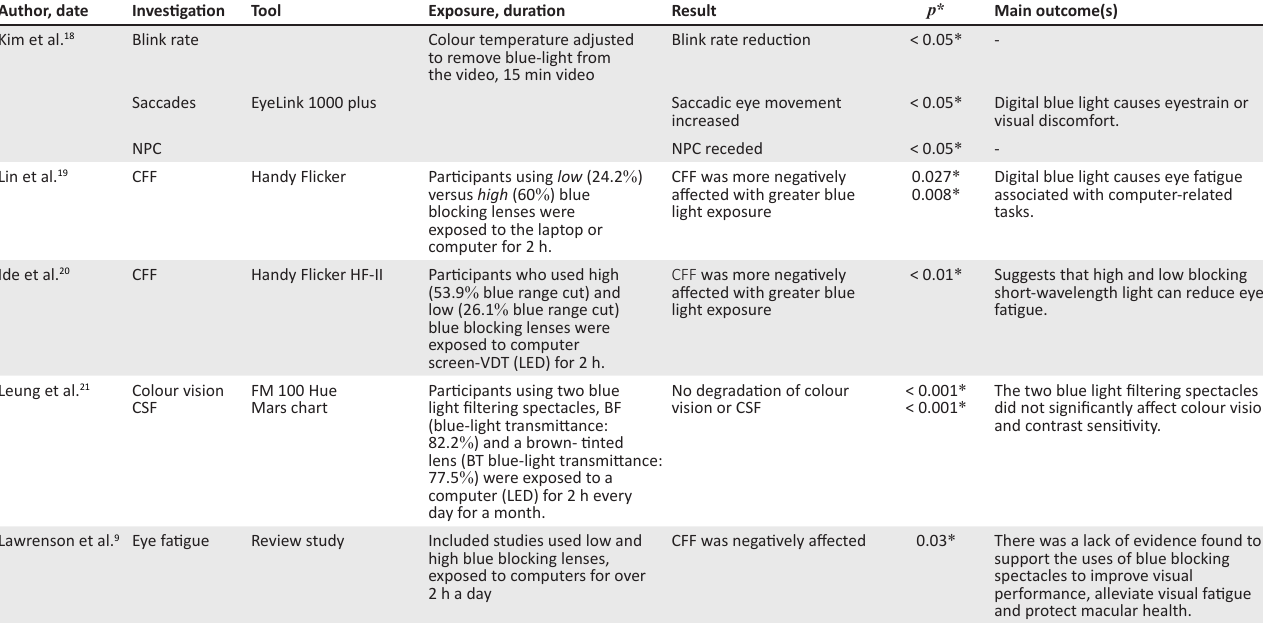
TABLE 2: Characteristics of included studies on effects of digital blue light on